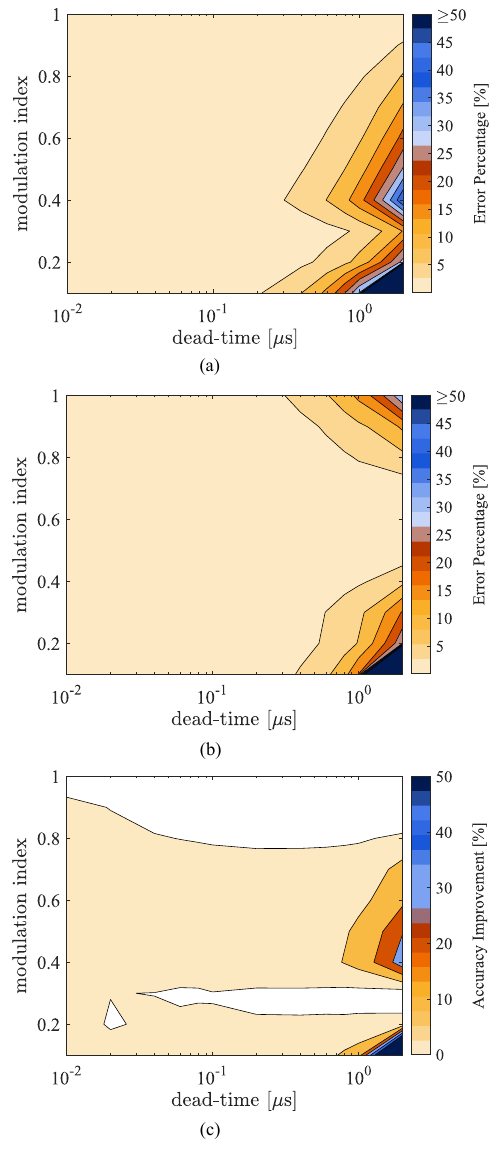
Figure 7. Absolute error percentage of the ( a ) benchmark and ( b ) proposed equations; ( c ) relative improvement of the proposed equations compared to the benchmark equations (case 1 load,